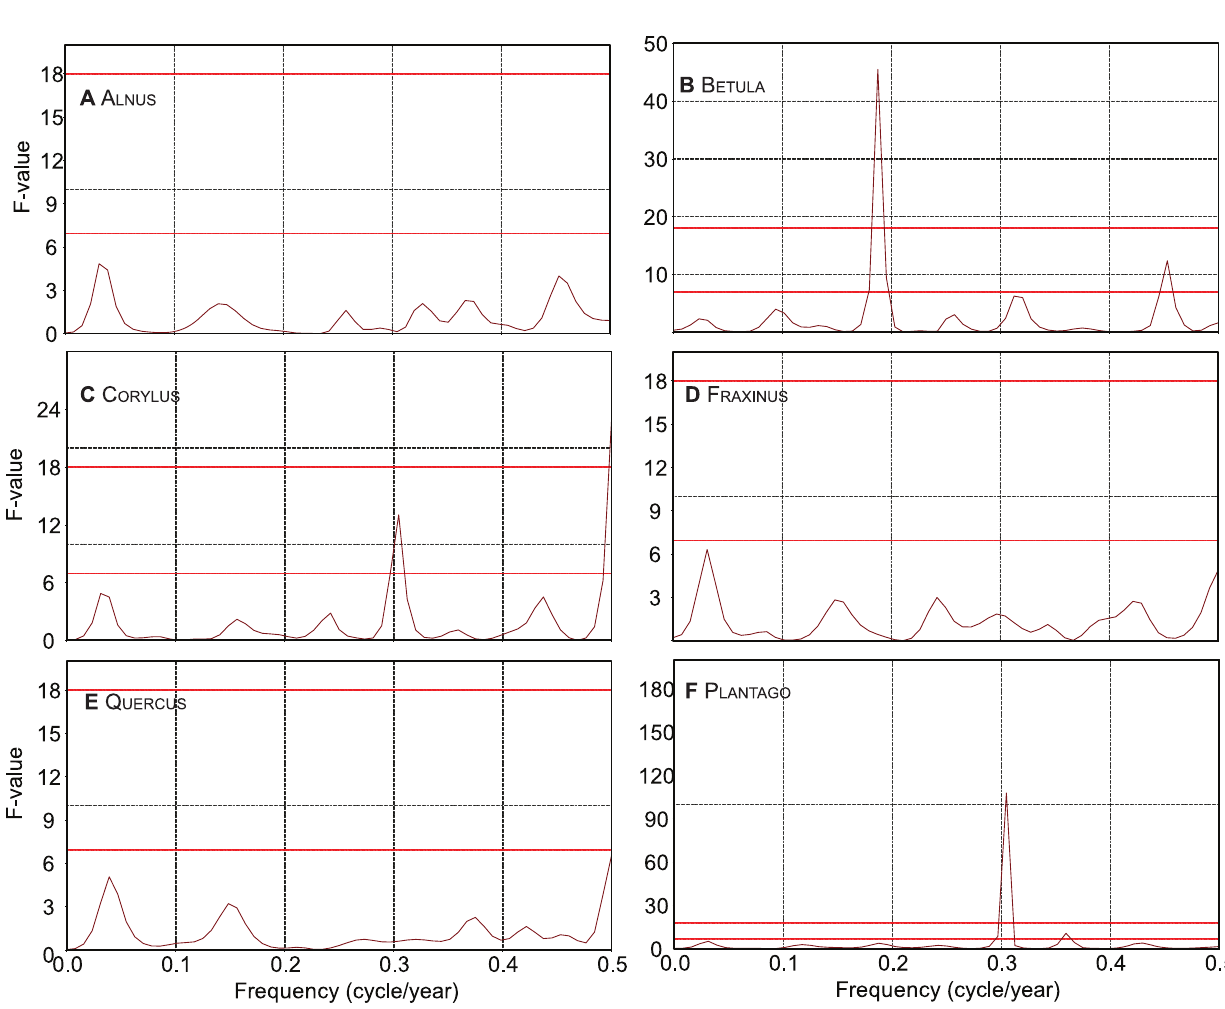
Figure 6. Spectral analysis output with 95% and 99% significance levels (upper and lower red line, respectively) of the 1969-2012 annual pollen influx time series in the LUMC trap. (a) A LNUS , (b) B ETULA , (c) C ORYLUS , (d) F RAXINUS , (e) Q UERCUS , and (f) P LANTAGO